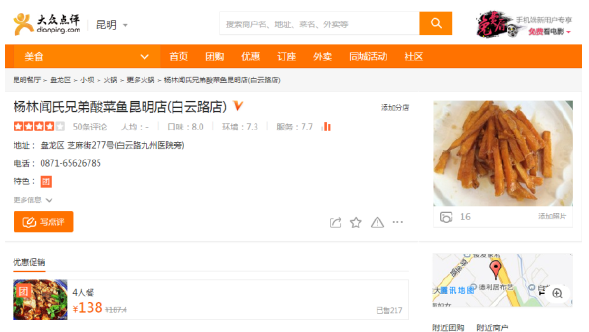
Figure 8. Services Mapped in the Historic Street